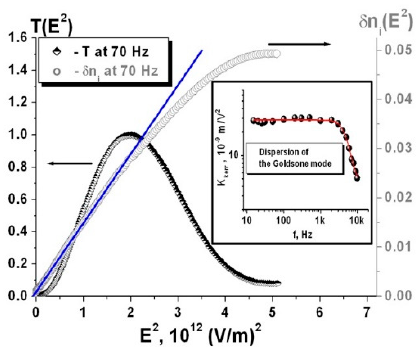
Figure 16. The dependence of transmittance and induced birefringence on amplitude of electric field for VADHF cell placed between crossed polarizers A at Ψ = 45° [40]. The solid blue line is the theoretical fitting. Insertion shows the frequency dependence of Kerr constant.